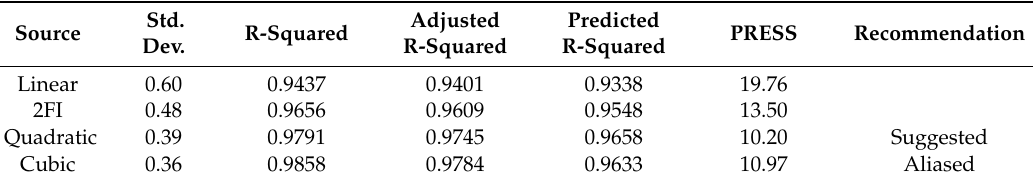
Table 5. Statistical summary of wear rate model.